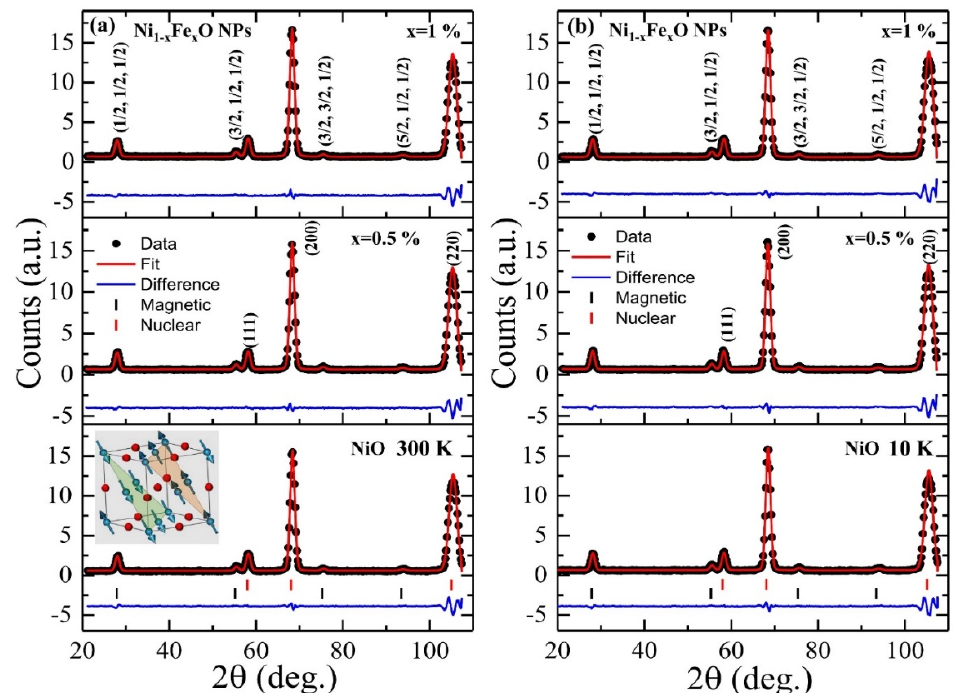
Figure 2. The Rietveld refined (red line) neutron powder diffraction (NPD) spectra (dots) from NiO, 0.5, and 1% samples (bottom to top) taken at ( a ) 300 K and ( b ) 10 K are calculated with Fm 3 m symmetry. The blue line represents the difference between experimental and fitted spectra. The vertical black and short red lines represent the magnetic and nuclear brags reflection positions. Inset in the bottom panel of ( a ): a unit cell of NiO with two magnetic sublattices.